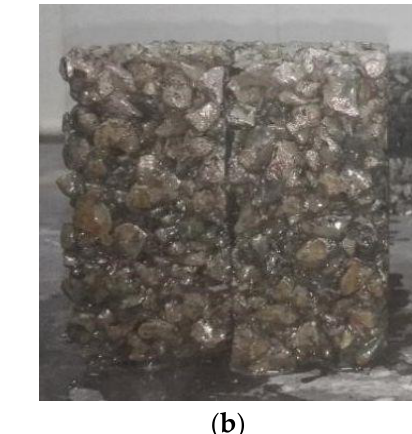
( b ) Figure 7. ( a ) The diagram of the method of cutting the surfaces for the thickness distribution of the paste analysis, and ( b ) the real specimen after cutting. The total porosity and connect porosity of pervious concrete were measured according to the methodology suggested by Jang [34] and multiple standards [39,40] and reports [41,42], where the total porosity, i.e., all the porosity in the pervious concrete, was suggested to correlate to the strength of pervious concrete, and the connect porosity, i.e., the pores with at least one open to the surface of pervious concrete, was suggested to correlate to the permeability of pervious concrete. Presumably, a pervious concrete with higher connect porosity could result in higher water permeability. The total porosity and connect porosity were calculated as follows: 